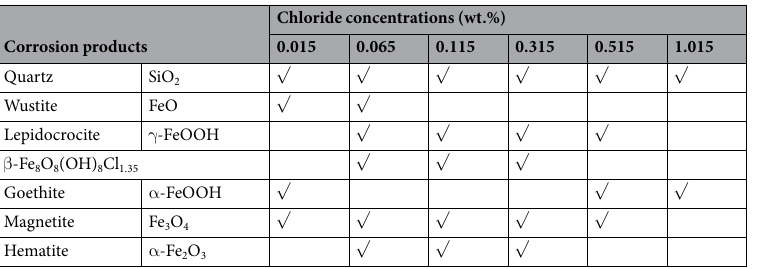
Chloride concentrations (wt.%)